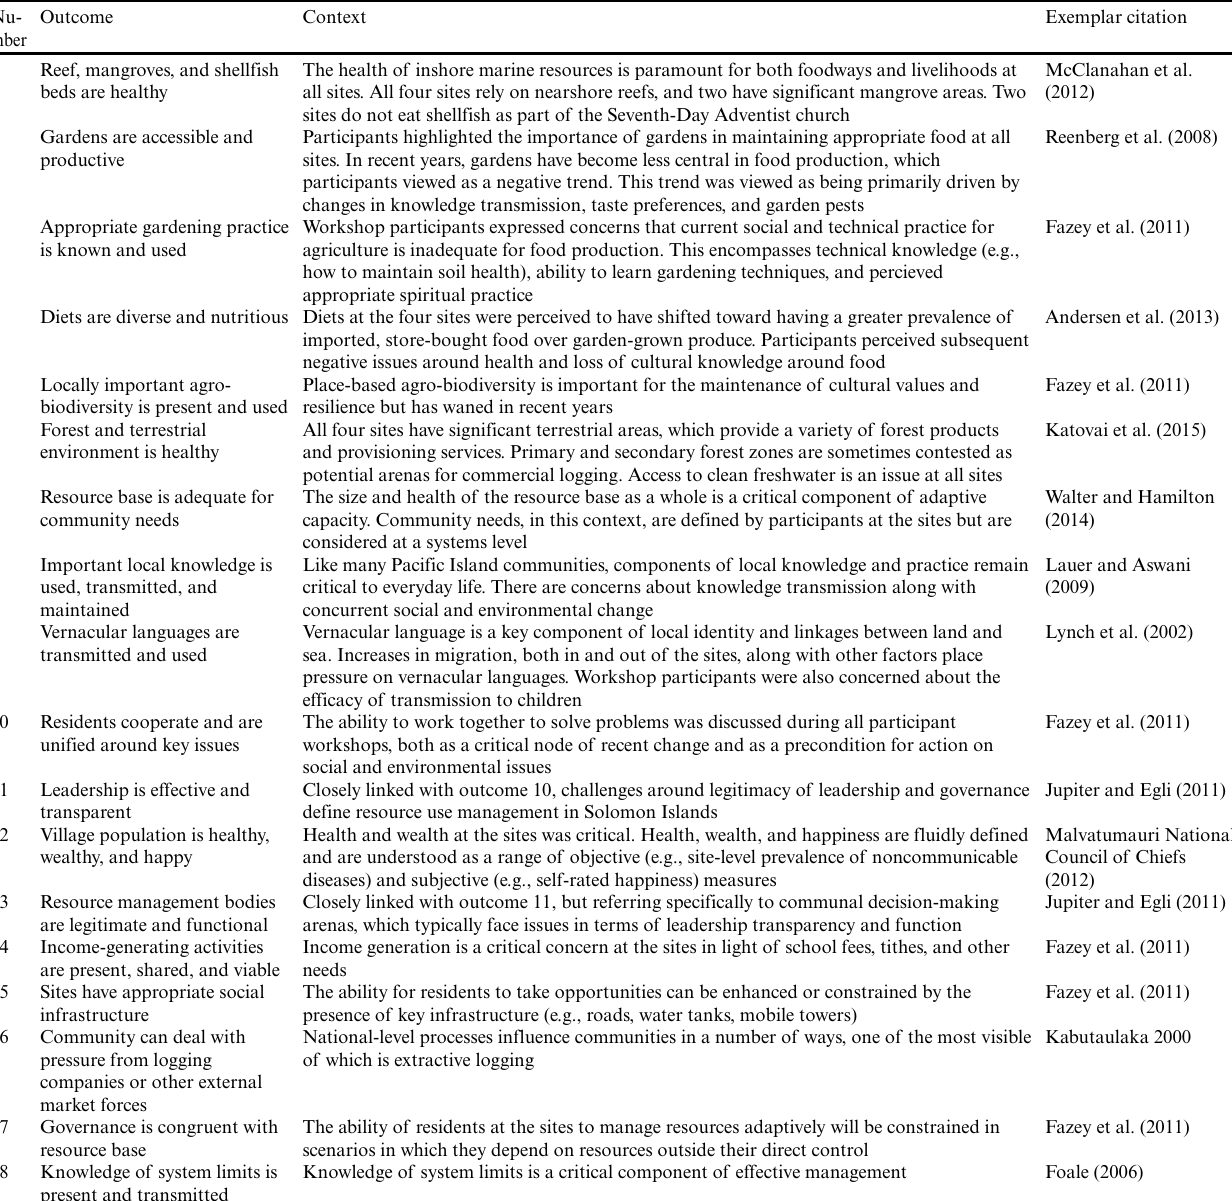
Table 2. Desired outcomes and components of well-being at the four sites, Western Province, Solomon Islands. Outcomes 1–16 were developed from visioning workshops at the sites; outcomes 17 and 18 were added after consulting the